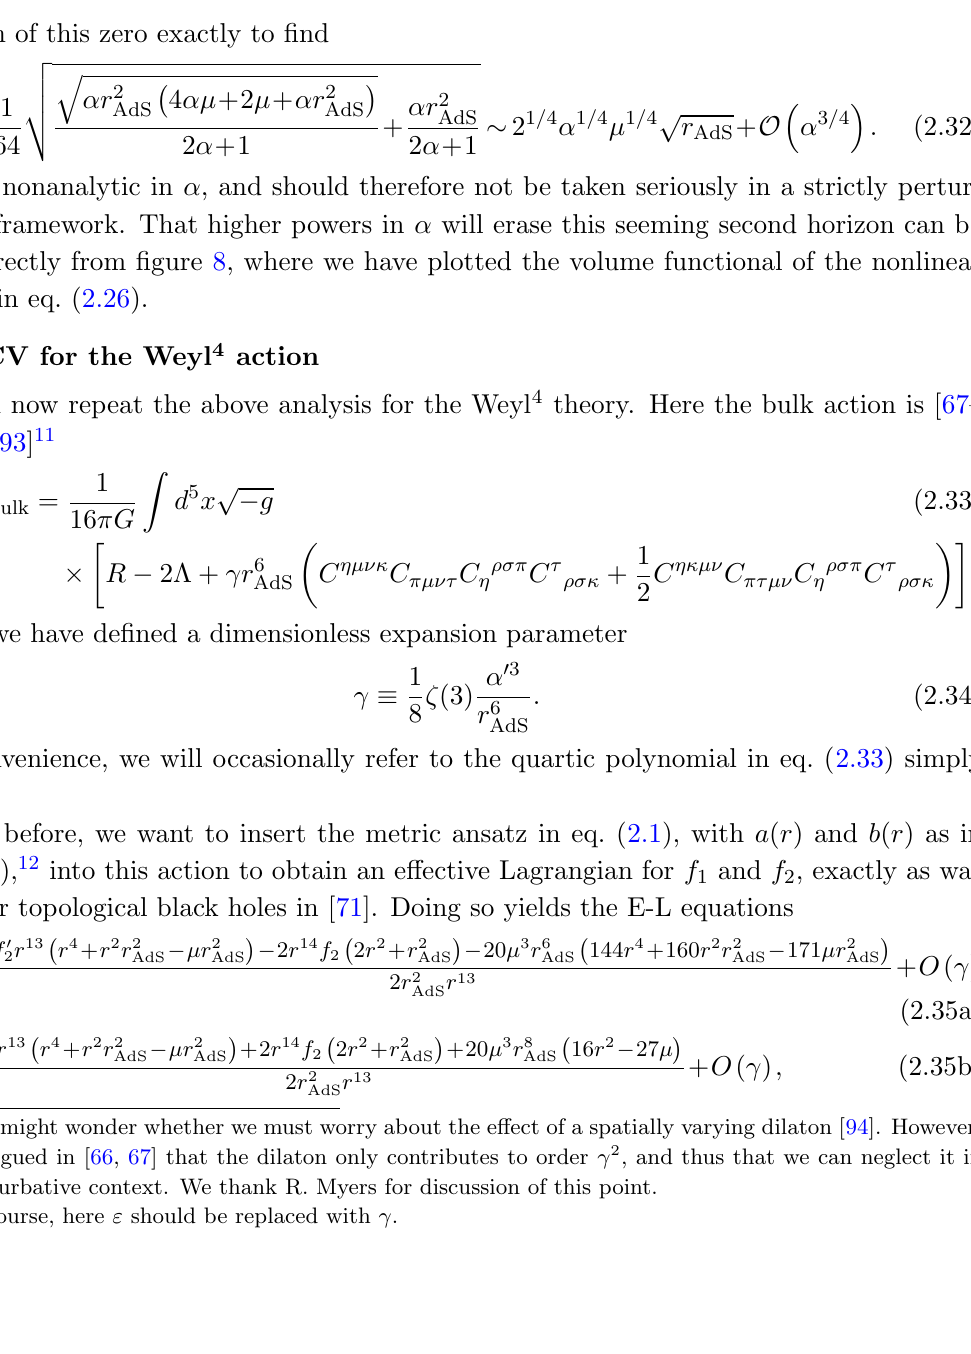
2 for the GB metrics in eq. (2.23) and (2.26). We can see that Figure 8. Simultaneous plots of V 2 in the linearized metric goes away upon inclusion of nonlinear the apparent negativity of V